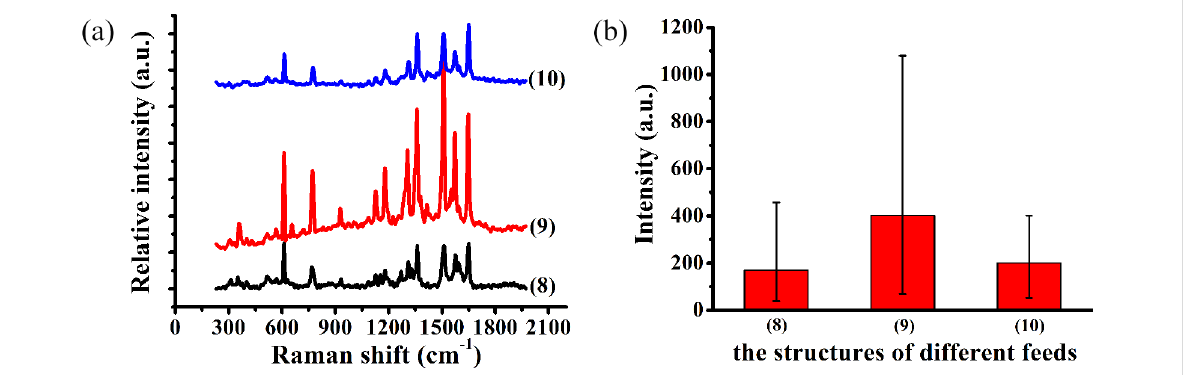
Figure 8: (a) Raman spectra of R6G molecules at 10 − 8 mol/L with different feeds on Ag/Cu substrates with a corrosion time of 10 minutes. (b) Aver- age Raman intensity of the 1362 cm − 1 peak of R6G for the Ag/Cu substrates with different feeds. The details of the structures (8), (9) and (10) are given in Table 1.